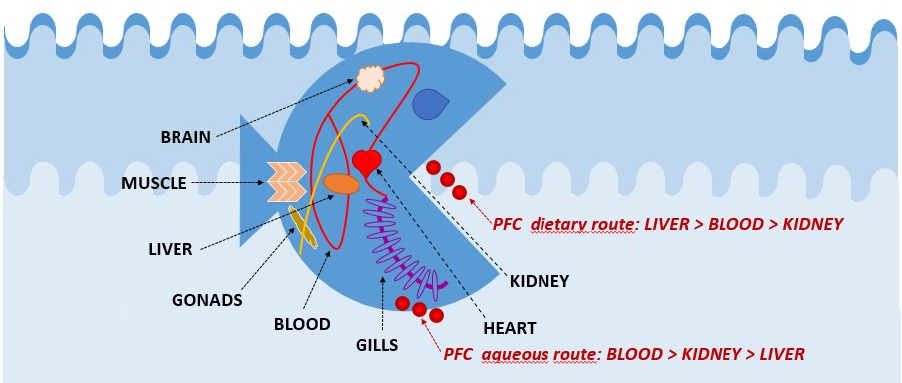
Figure 2. Scheme of preferred tissues for the biodistribution of PFCs in fish.